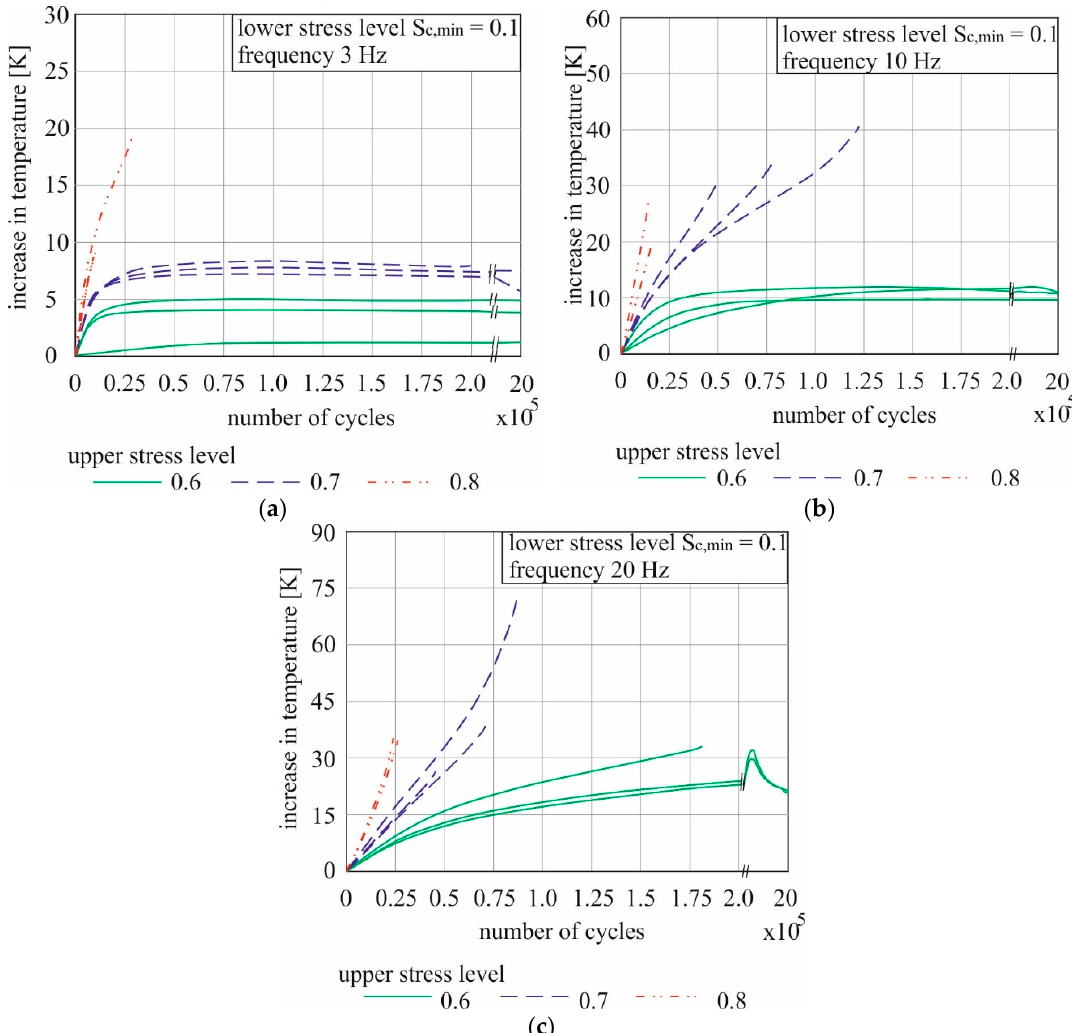
Figure 5. Temperature development of all UHPC 1 specimens for maximum stress level of 0.6, 0.7 and 0.8 ( a ) frequency of 3 Hz; ( b ) frequency of 10 Hz; ( c ) frequency of 20 Hz.